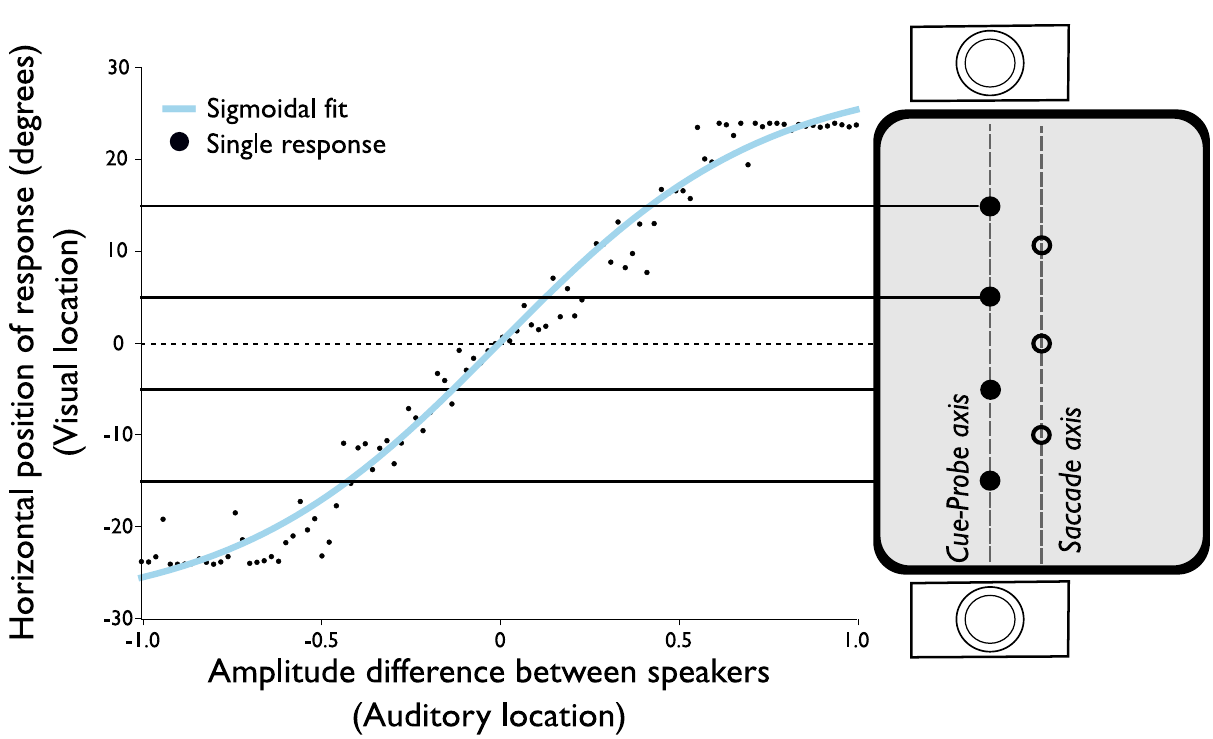
Fig 2. Sigmoid fit of pointing responses to auditory locations of a single participant in the matching task. The black dots show the participant’s localization response to a panned white-noise stimulus. The blue line shows the sigmoid fit to the responses. The locations of the probes used in the auditory block are superimposed on the right side and are connected via a black line. Note that the illustration of the screen is rotated by 90 degrees here, with respect to Fig 1, to align the stimulus location with the vertical axis in the graph.